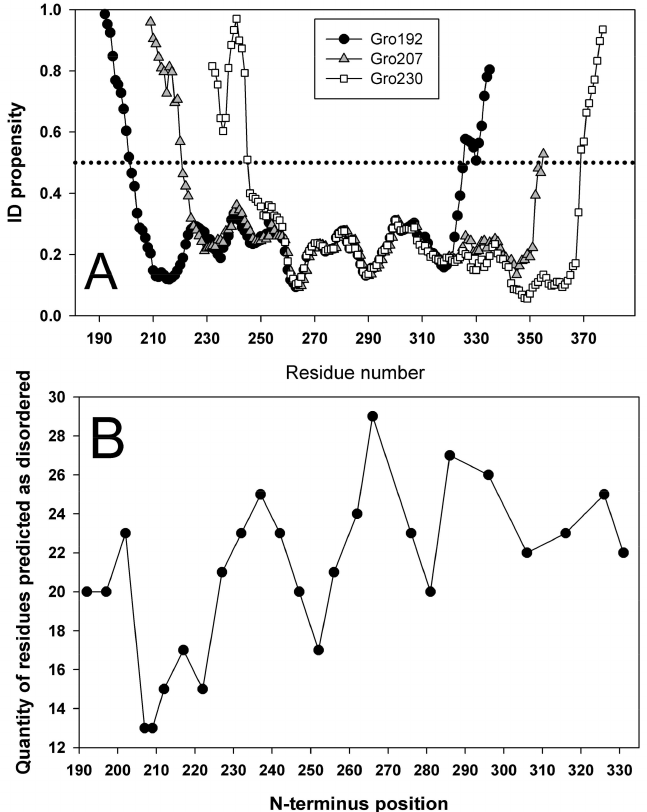
Figure 11. ( A ) Intrinsic disorder propensities (IDP) for amino acid sequence calculated for Gro192, apical domain of wild type GroEL cleaved from GroEL protein by 192 and 335 amino acid residue; Gro207 is a domain with N– and C–termini (a.a. 192, 335) tailored by a linker, and a cleavage (novel N– and C–ends) made at residue 207; Gro230 is a circular permutant with cleavage at a.a. 230. ( B ) Dependency of number of amino acid residues with IDP > 0.5 on the position of cleavage